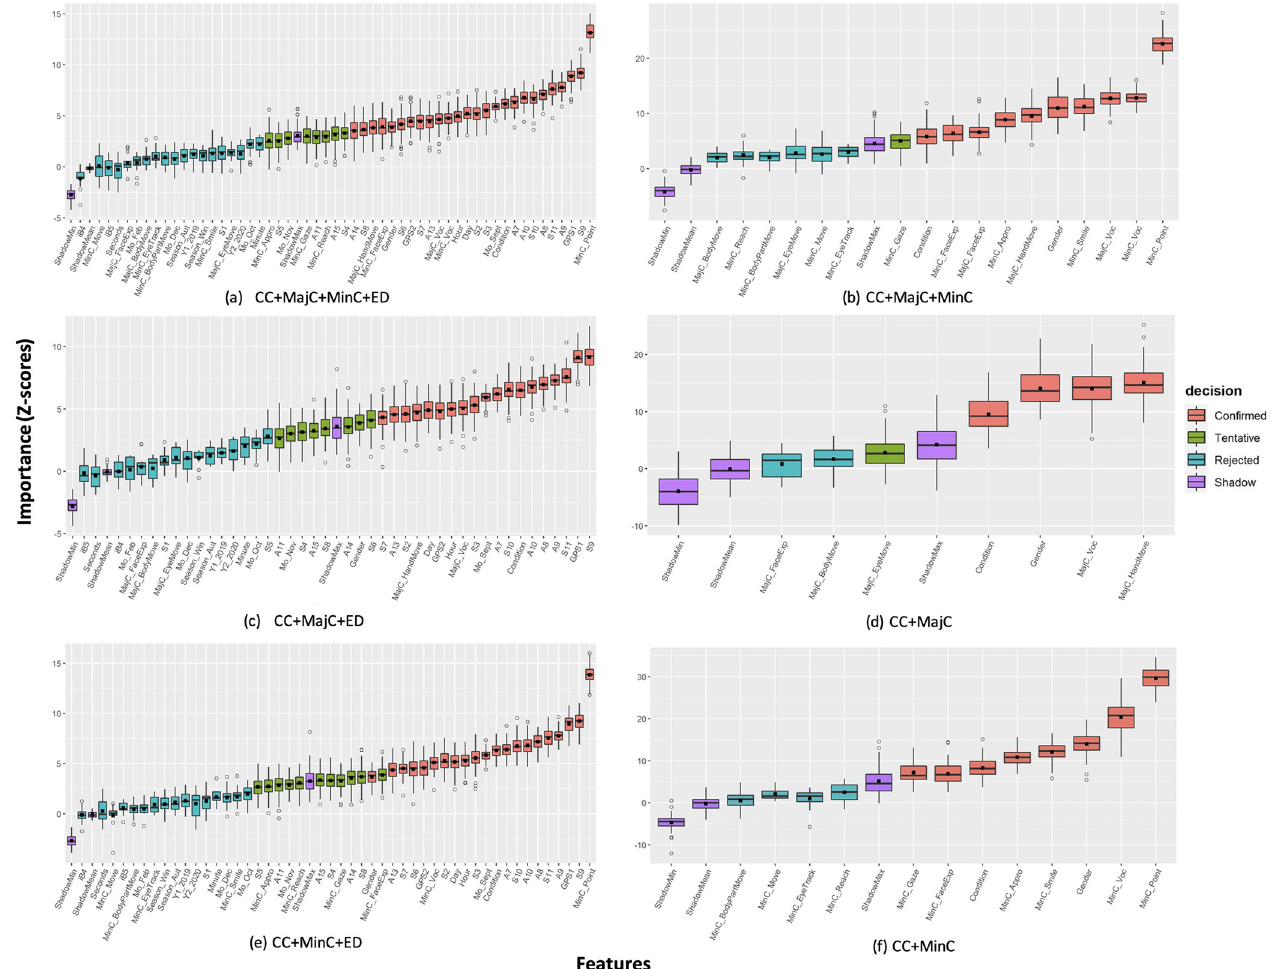
Fig 7. Variable importance ranking based on Boruta feature selection method in class 3. CC = child characteristics; MajC = major movement category; MinC = minor movement category; ED = environment data; Condition = PIMD or IDs; MinC_Gaze = gazing; MinC_ChangeLOS = changing line of sight; MinC_FaceExp = facial expression (other than smile); MinC_Voc = vocalization as minor category; MinC_Point = pointing; MinC_Reach = reaching; MinC_Move = moving; MinC_Appro = approaching; MinC_BodyPartMove = movement of a part of the body; MajC_EyeMove = eye movement; MajC_FaceExp = facial expressions; MajC_Voc = vocalization as major category; MajC_HandMove = hand movements; MajC_BodyMove = body movements; GPS1: Longitude; GPS2: Latitude; iB4 = classroom; iB5 = other iBeacon device; S1: Ultraviolet (UV) range (mW/cm2); S2, S3, S4: 6-axis (Accel+Geomag) sensor ranges [g]; S5, S6, S7: 6-axis (Accel+Geomag) sensor resolutions [ μ T]; S8: UV resolution [Lx]; S9: Pressure sensor range (hPa); S10: Temperature and humidity sensor range (˚C); S11: Temperature and humidity sensor resolution (%RH); A7: Minimum temperature (˚C); A8: Maximum temperature (˚C); A9: Atmospheric pressure (hPa); A10: Main temperature (˚C); A11: Humidity (%); A13: Cloudiness (%); A14: Wind direction (degrees); A15: Wind speed (meters/ second); Mo_Feb = February; Mo_Sept = September; Mo_Oct = October; Mo_Nov = November; Mo_Dec = December; ShadowMin = minimum Z-score of a shadow attribute; ShadowMax = minimum Z-score of a shadow attribute; ShadowMean = average Z-score of a shadow attribute.